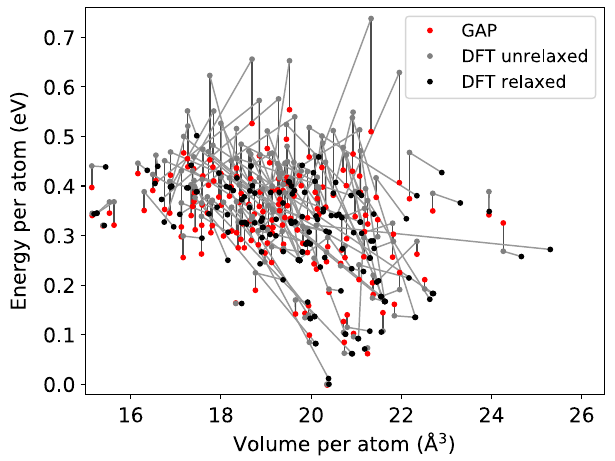
FIG. 17. Energies and volumes of relaxation of GAP RSS minima with DFT forces and stresses. Red circles indicate GAP minima, gray circles indicate DFT energies of GAP minima configurations, and black circles indicate the energy and volume of DFT-relaxed configurations starting from the corresponding GAP minimum.